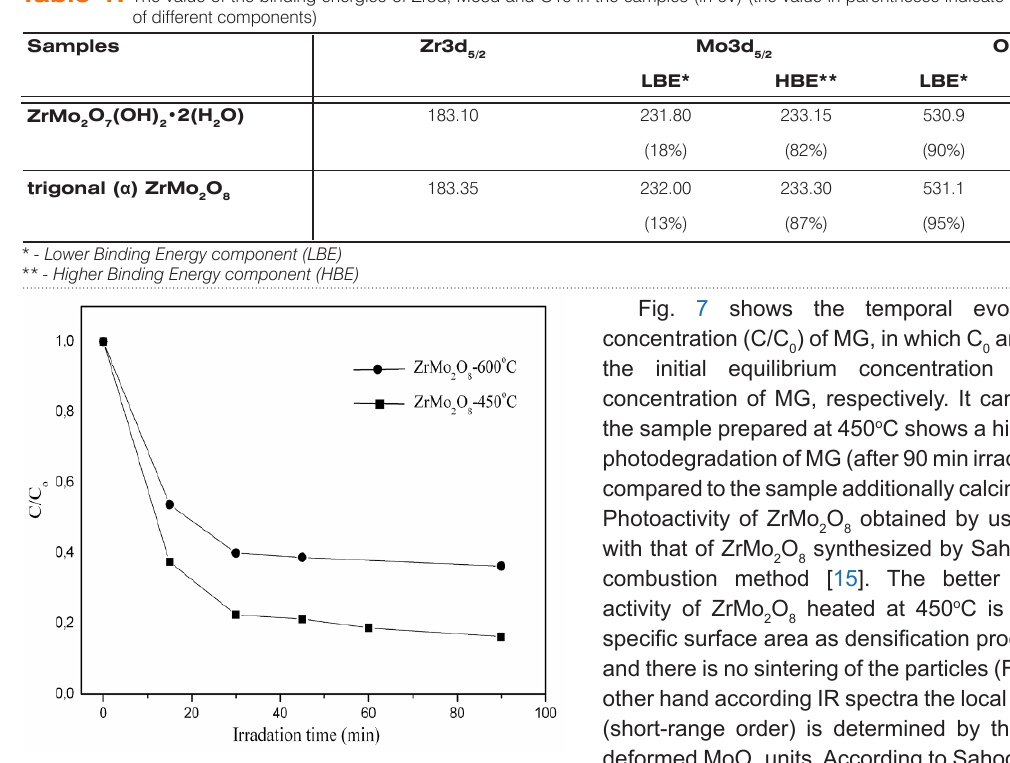
Figure 7. Photodecomposition of the MG during UV-light irradiation O by ZrMo 2 8